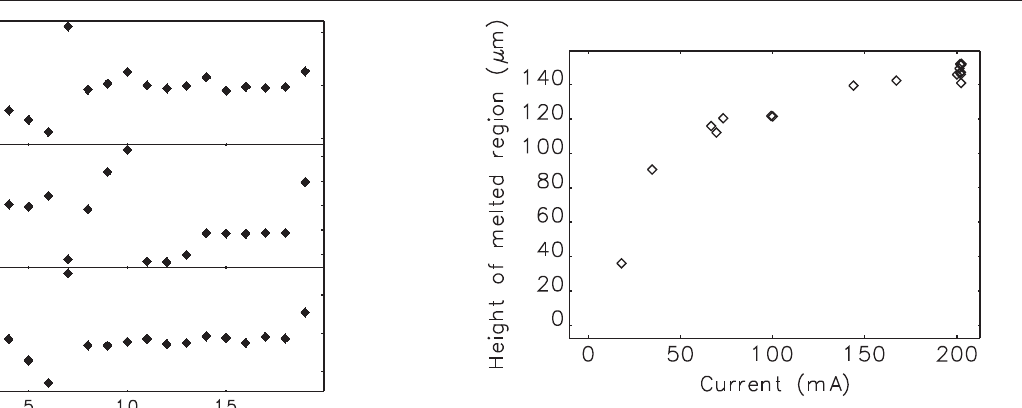
FIG. 6. Vertical extent of the liquified-aluminum region for the second collimator experiment, based on the thermally diffused simulated dose